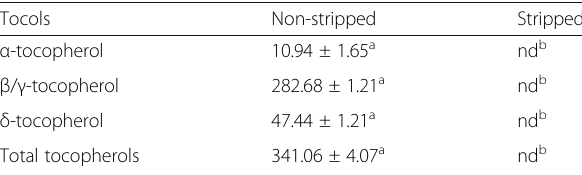
Table 3 Tocol concentration (mg/kg of oil) in the original non- stripped and stripped chia seed oil 1,2 Tocols